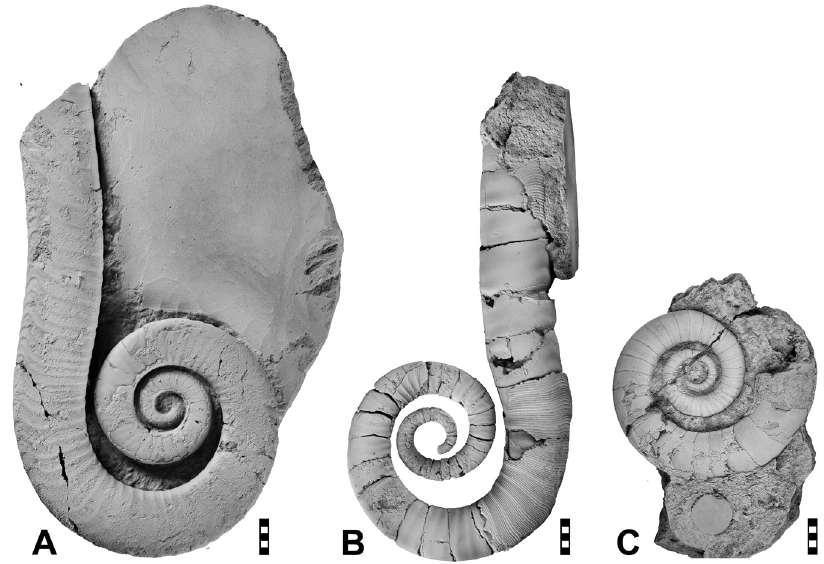
Fig. 38. Lituites perfectus Wahlenberg, 1818 from the Upper Grey Orthoceratite Limestone. A . Neotype MB.C.30544 (Krueger Coll.) from Lansen near Malchin (Mecklenburg-Vorpommern, Germany). B . Specimen MB.C.30542 (Neben Coll.) from Niederfinow (Brandenburg). C . Specimen MB.C.11646 (Kgl. Forstakademie Eberswalde Coll.) from Eberswalde (Brandenburg). Scale bar units = 1